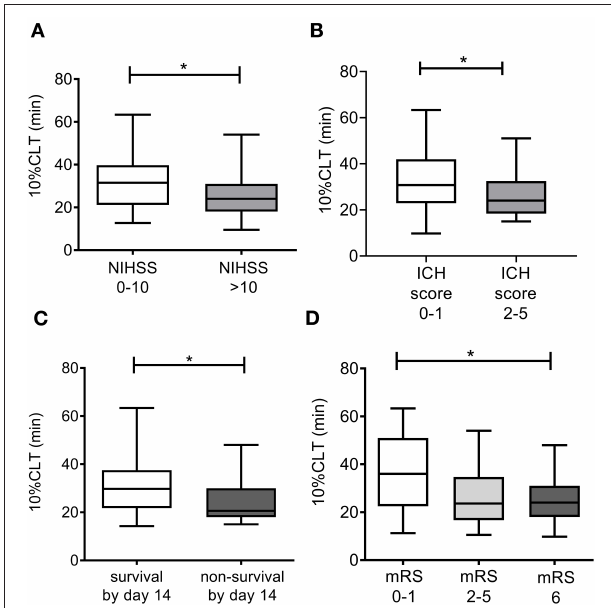
FIGURE 1 | Associations of the 10%CLT parameter of the modified clot lysis assay (mCLA) with stroke severity on admission (A) , ICH score calculated on admission (B) , survival by day 14 (C) , and the modified Rankin Scale (mRS) on day 90 (D) . mCLA is performed in the presence of cell-free DNA and histones. Box and whisker plots indicate median, interquartile range, and total range. 10% CLT: 10% clot lysis time, ICH, intracerebral hemorrhage; NIHSS, National Institutes of Health Stroke Scale; mRS, modified Rankin Scale. * p < 0.05.